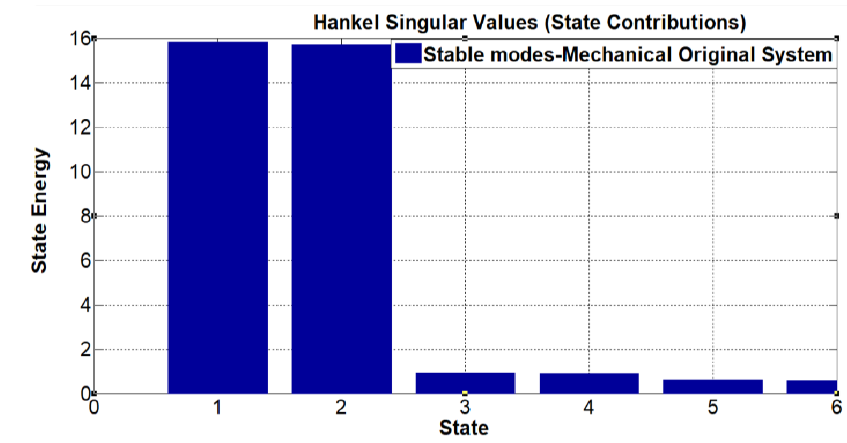
Figure 8. The bar chart in Hankel singular value plot of mechanical OS